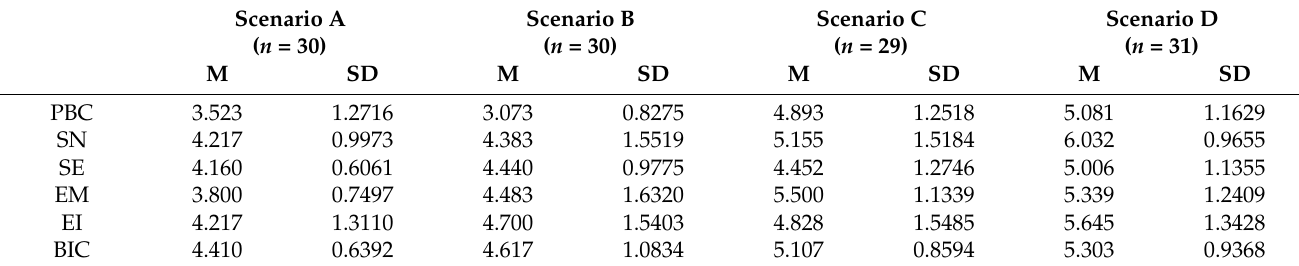
Table 5. Statistics of involved variables under the four scenarios.